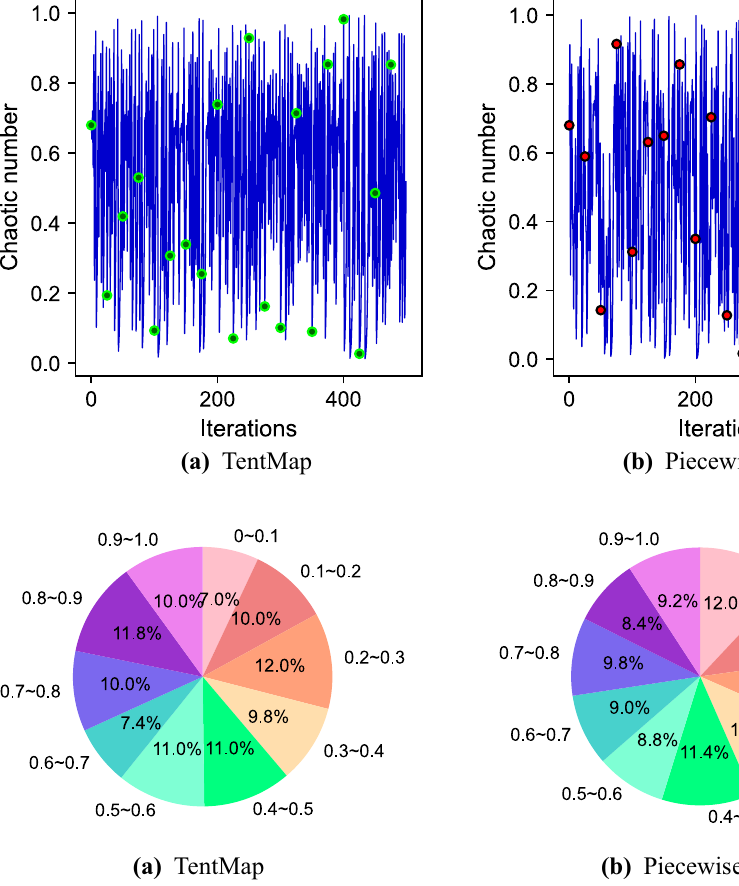
Fig. 5 Waveforms of piecewise linear and tent mapping